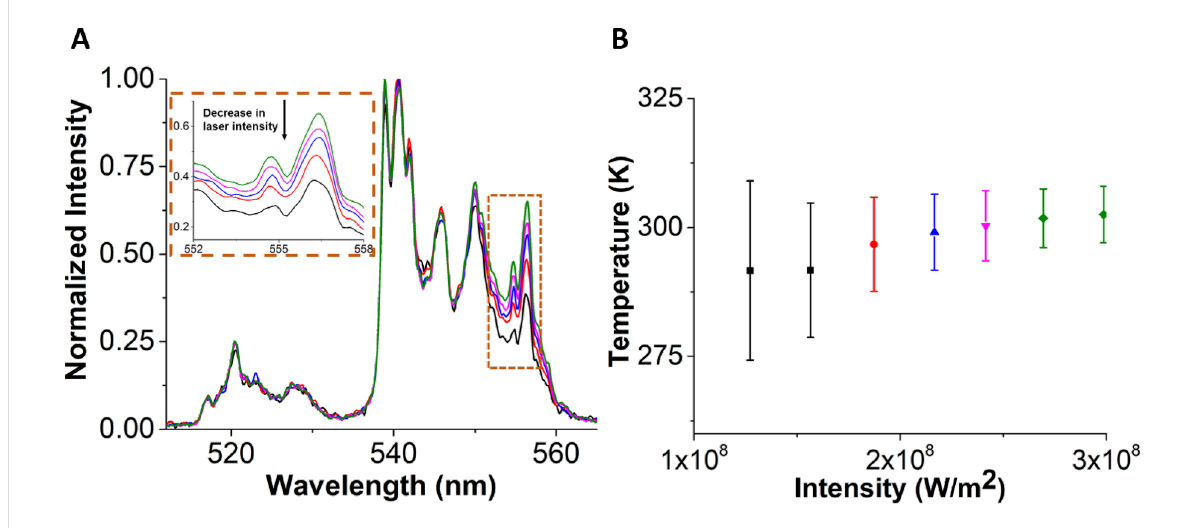
S-band changes with temperature [35]. The LIR is used to calculate the absolute temperature using the Boltzmann relationship. Here we use H-band (514–534 nm) and S-band (536–548 nm) peak areas for LIR. Figure 2A represents the area of H- and S-band of UCNPs shaded in green and brown, respec- tively. We changed the temperature of a coverslip with UCNPs on it, from 306 to 493K and collected the spectra using an α -300 SNOM Witec microscope with optical-fiber-coupled monochromator. Figure 2B represents the plot of natural log of LIR vs 1/ T where T is the recorded temperature. A linear fit gives a slope value of − 1182 ± 8.0 K and the intercept is 3.002 ±